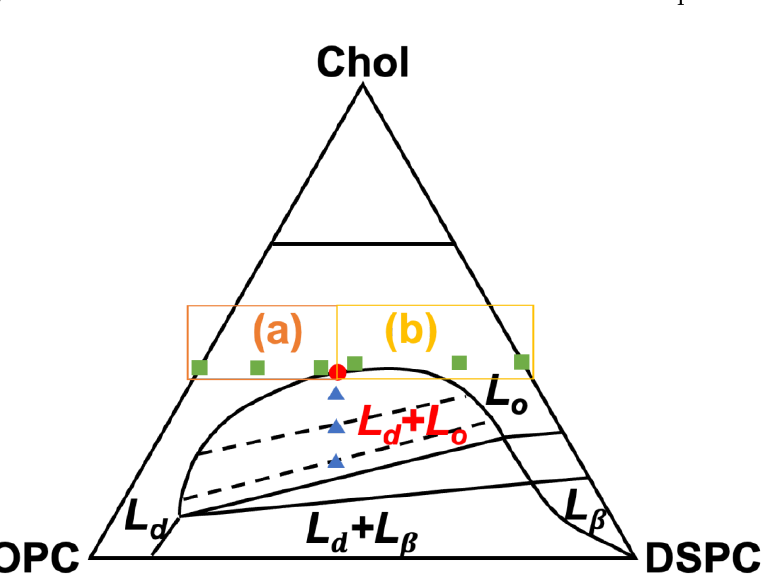
Figure 1. Schematic of the ternary phase diagram for the lipid membranes of DOPC/DSPC/cholesterol (Chol) at 22 ◦ C, based on ref. [13]. L d , L o , and L β are the liquid-disordered, liquid-ordered, and solid-gel phases, respectively, for the in-plane organization of the membranes. The filled circle is the miscibility critical point. The compositions of the homogeneous and laterally heterogeneous membranes are marked by filled squares and triangles, respectively. Rectangles mark two compositional regimes, (a) and (b), where the fusion extent of the homogeneous membranes behaved distinctly.